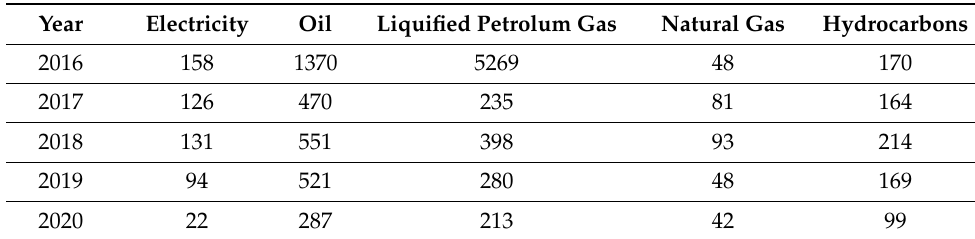
Table 7. Permits granted by CRE in